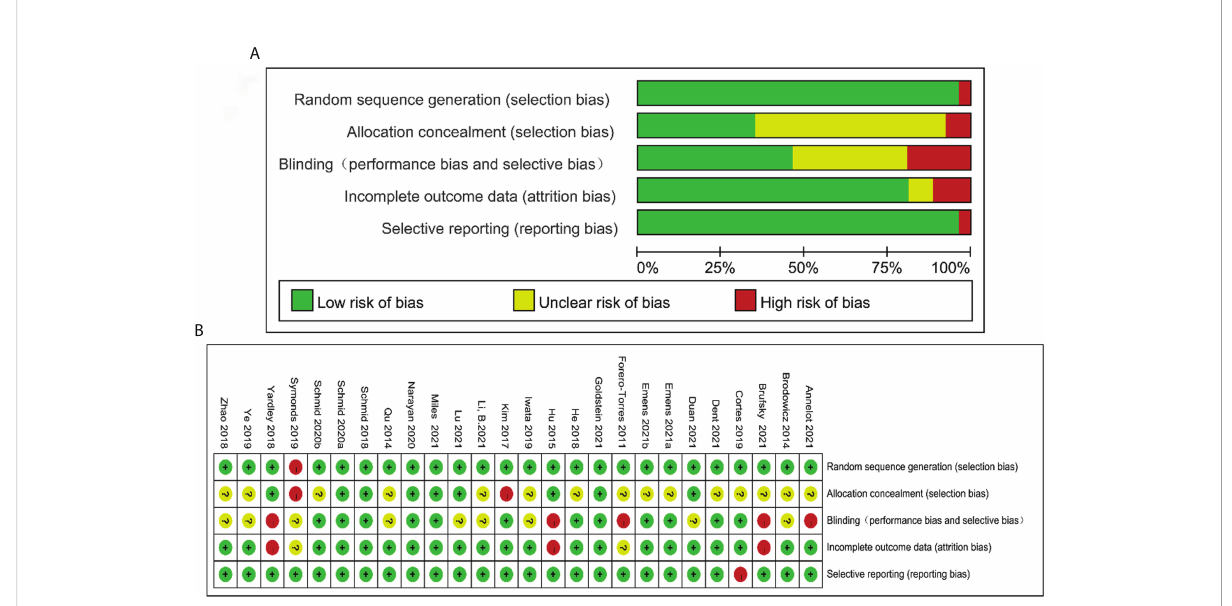
FIGURE 2 Risk of bias graph: reviewers ’ judgments about each risk of bias item presented as percentages across all included studies (A) . Risk of bias summary: reviewers ’ judgments about each risk of bias item for each included study according to the Cochrane Collaboration ’ s “ Risk of Bias ” tool, the green circle with “ plus ” sign low risk of bias information, the yellow circle with “ question mark ” sign representing unclear risk of bias information, and the red circle with “ minus ” sign representing high risk of bias information (B)